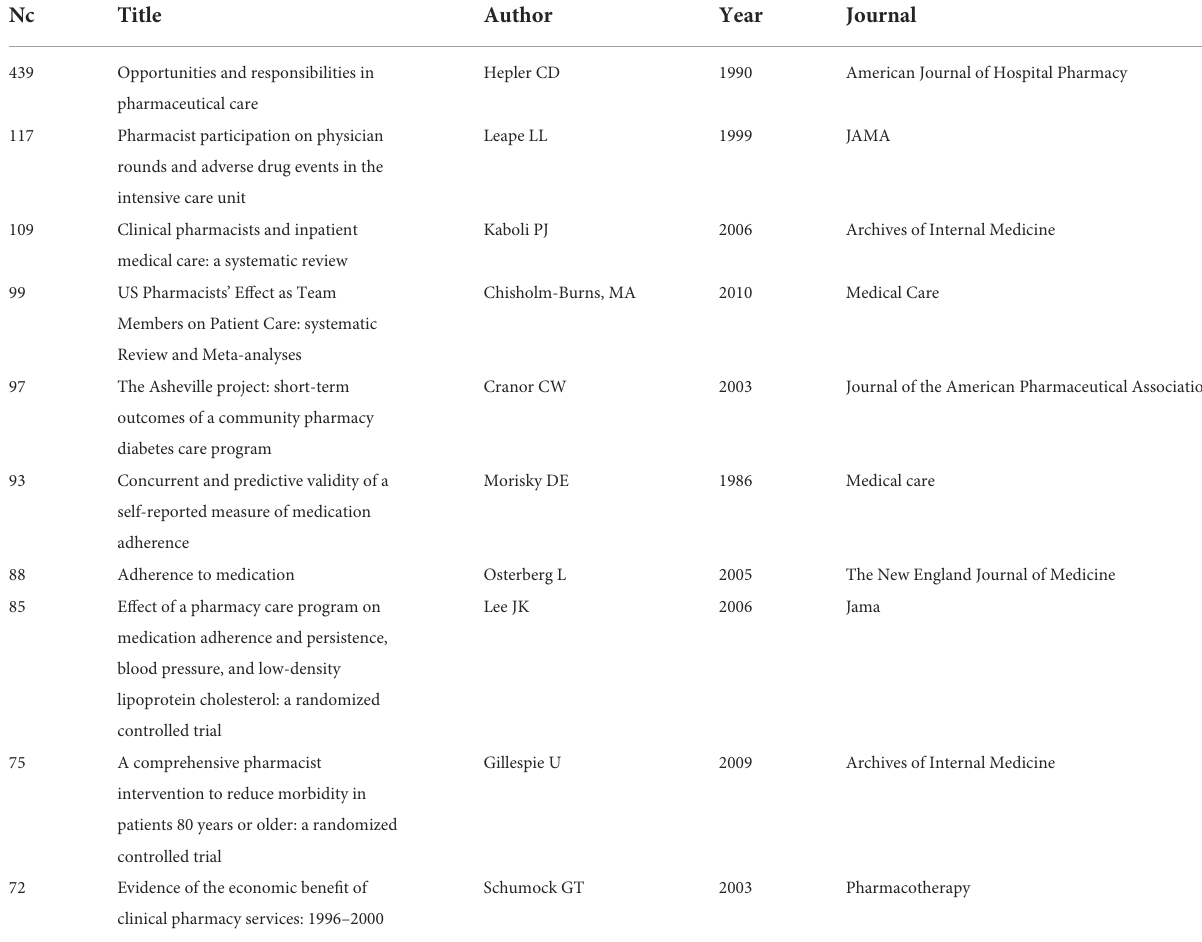
TABLE 2 The top 10 co-cited references in the field of pharmaceutical